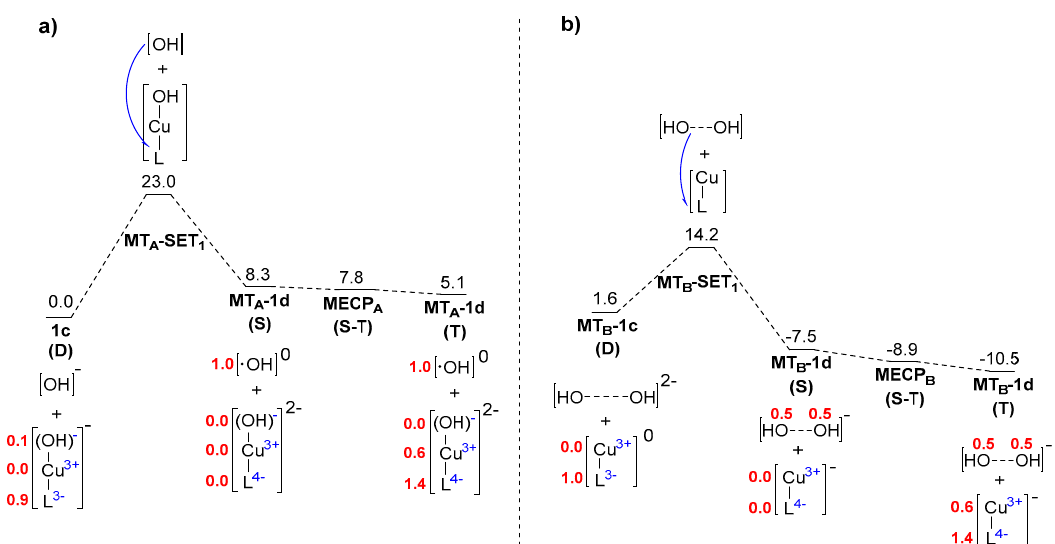
Figure 3. ( a ) Model A for the study of the outer-sphere SET from a OH − moiety to 1c complex applying Marcus theory. ( b ) Model B for the study of the outer-sphere SET from a cluster of two OH − moieties to the neutral form of the catalyst, MT B -1c . Free energies in kcal/mol. Red numbers correspond to the spin population.